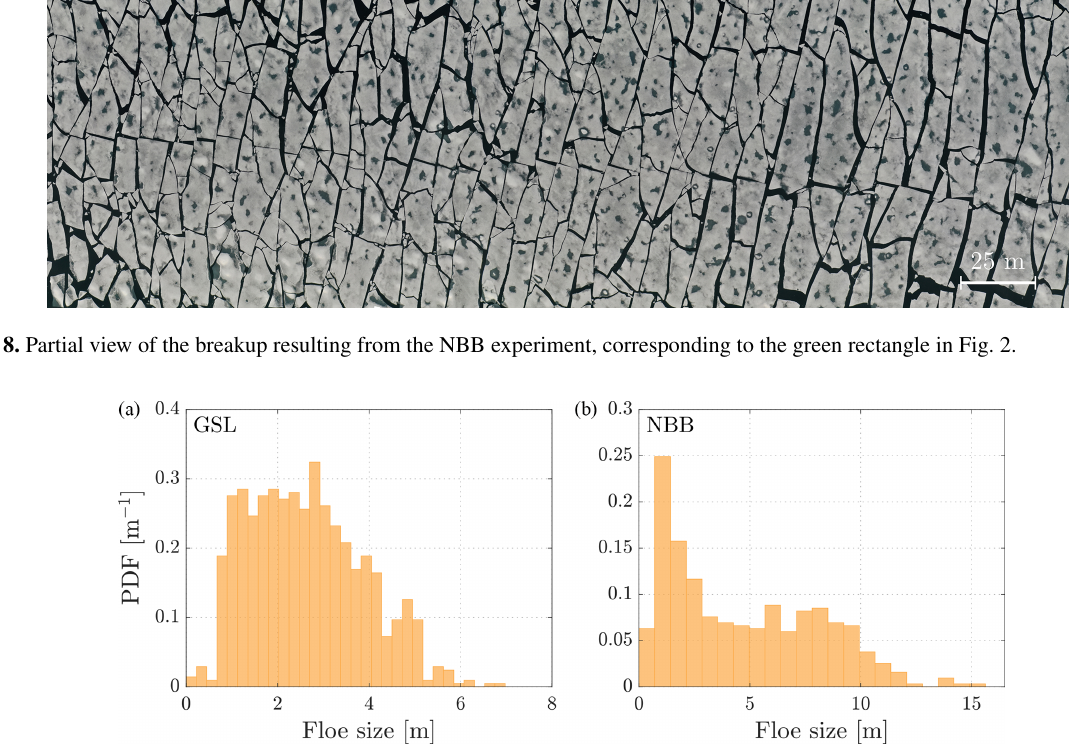
Figure 9. Number-based probability density functions of floe size (NFSDs) resulting from the breakup